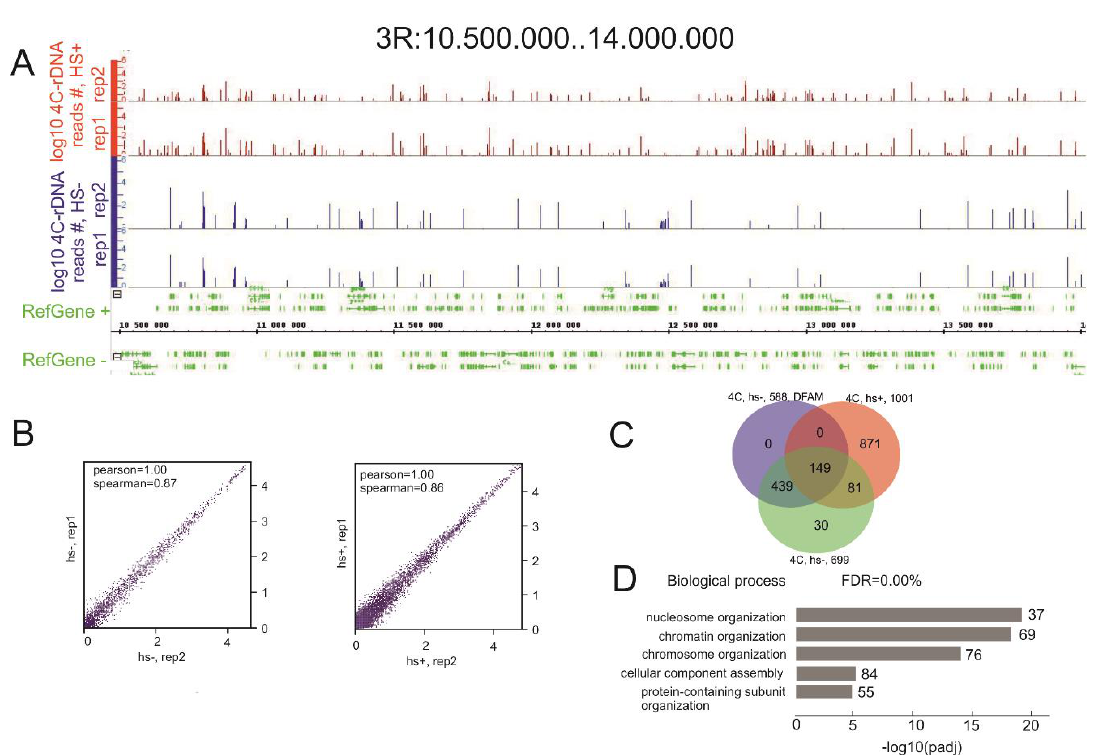
Figure 1. General characteristics of the mapped 4C-rDNA reads. ( A ) The position of rDNA contacts around the 500-kb region of 3R. The mapped reads without a threshold are shown for two replicates corresponding to the normal and heat-shock-treated S2 cells. The data for normal cells are shown in blue and for heat-treated cells in red. ( B ) Scatterplots show the consistency between the 4C-rDNA replicates for the normal (HS-) and heat-shock-treated S2 cells (HS+). ( C ) A Venn diagram shows the intersections between rDNA-contacting genes selected by the threshold of 100 4C-rDNA reads corresponding to a gene without Dfam filtering (699 genes), after filtering to remove the reads entirely corresponding to repetitive sequences (588 genes), and to rDNA-contacting genes detected after heat shock treatment (1001 genes). The list of the genes corresponding to the Venn diagram is shown in Table S1. GO associations of 149 rDNA-contacting genes indicated in the Venn diagram are shown in Table S2. GO associations of 588 rDNA-contacting genes are shown in Table S3. GO associations of 871 genes indicated in the Venn diagram are shown in Table S4. ( D ) The top five detected terms of biological processes associated with the list of 588 rDNA-contacting genes. The values to the right of the bars show the number of rDNA-contacting genes associated with a term.